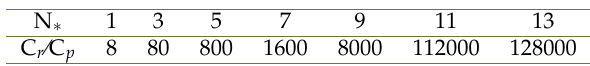
Table 4. Computed values of C r / C p and